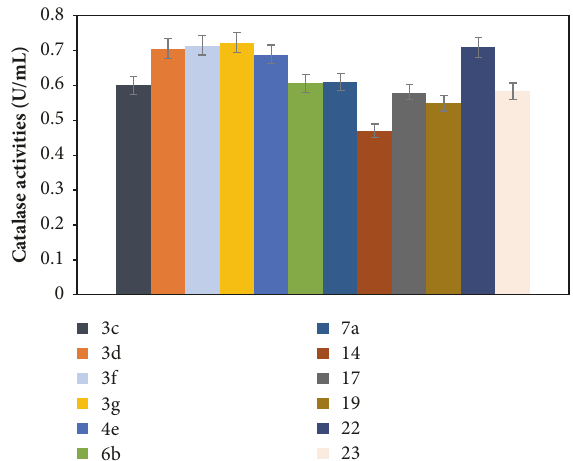
Figure 1: Catalase enzyme activities of the compounds, U mL - 1